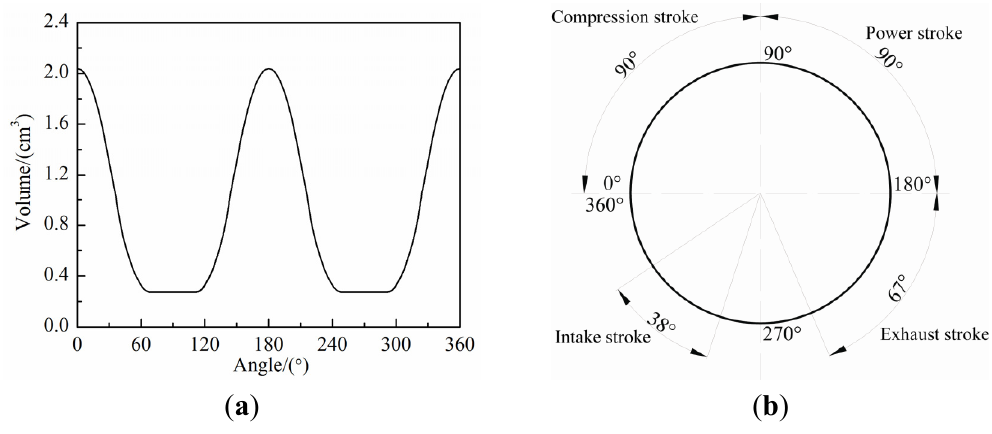
Figure 2. ( a ) Variation profile of combustion chamber volume; ( b ) The phase chart of the leaf spring rotary